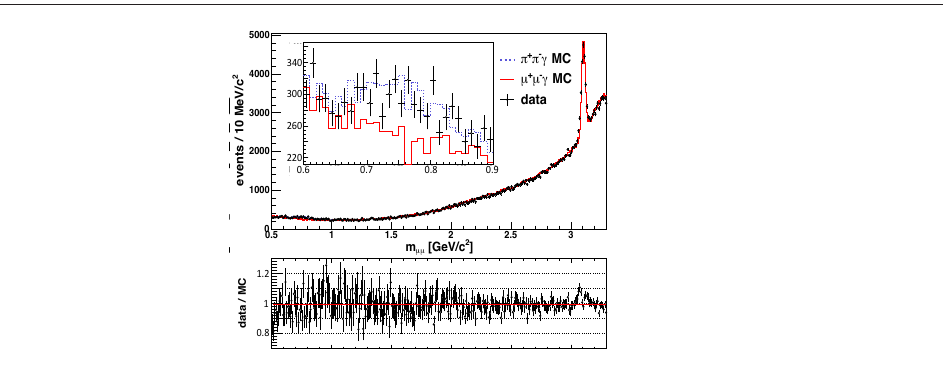
Figure 2. The comparison of (cid:22) + (cid:22) (cid:0) invariant mass distribution between data and MC simulation of e + e (cid:0) ! (cid:13) ISR (cid:22) + (cid:22) (cid:0) after selecting (cid:22) and applying the e ffi ciency corrections [13]. Table 2. The number of background events ( N ISR ) and the number of signal and background events ( N ISR + (cid:31) c 1 ) estimated with the prediction in [5]. Number of points N